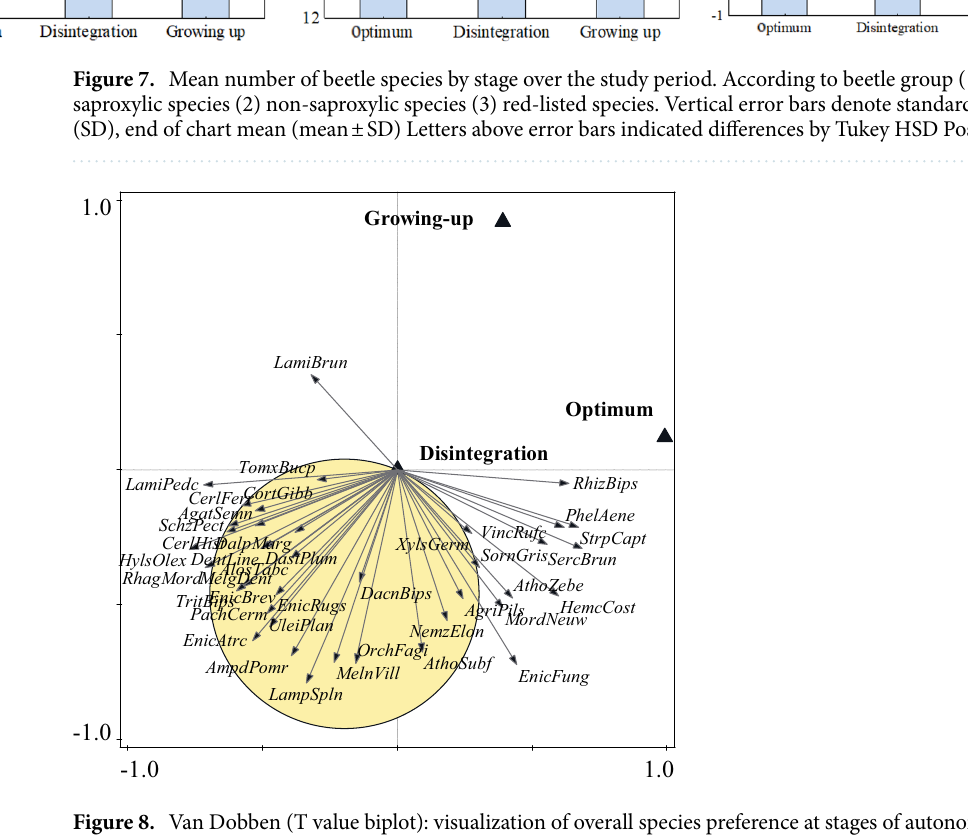
Figure 8. Van Dobben (T value biplot): visualization of overall species preference at stages of autonomous development of beech stands. Test of all canonical axes (pF 2.8; p = 0.002). The test was performed from the entire list of recorded species (N > 1), and the 40 best-fit species were selected for visualization. Species whose arrow ends in a yellow circle are significantly associated with the disintegration